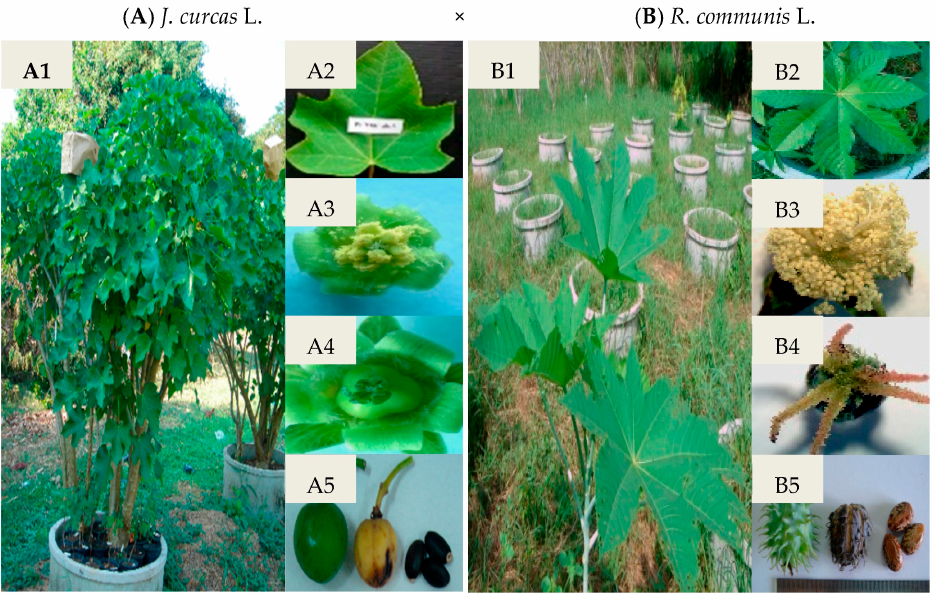
Figure 1. The morphology of J . curcas L. ( A1 ) plant, ( A2 ) leaf, ( A3 ) male flower, and ( A4 ) female flower, ( A5 ) fruits and seeds; R . communis L. ( B1 ) plant, ( B2 ) leaf, ( B3 ) male flower, ( B4 ) female flower, and ( B5 ) fruits and seeds.